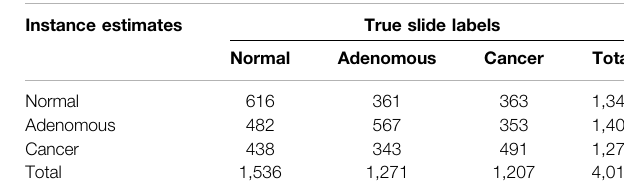
TABLE 4 | Confusion of seed instances between classi fi cations and slide